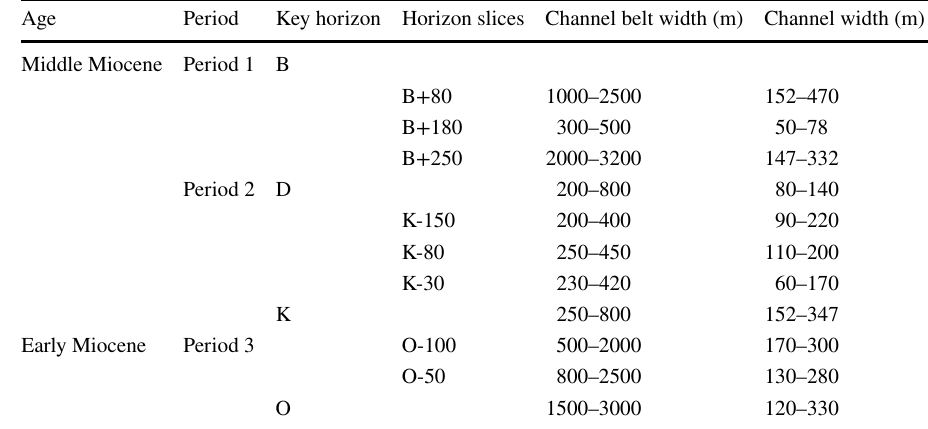
Table 1 The dimensions of the fluvial system parameters at different stratigraphic